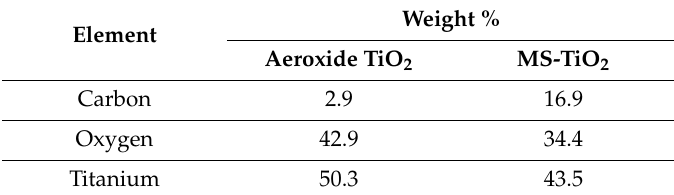
Table 1. EDX study of aeroxide TiO 2 and MS-TiO 2.